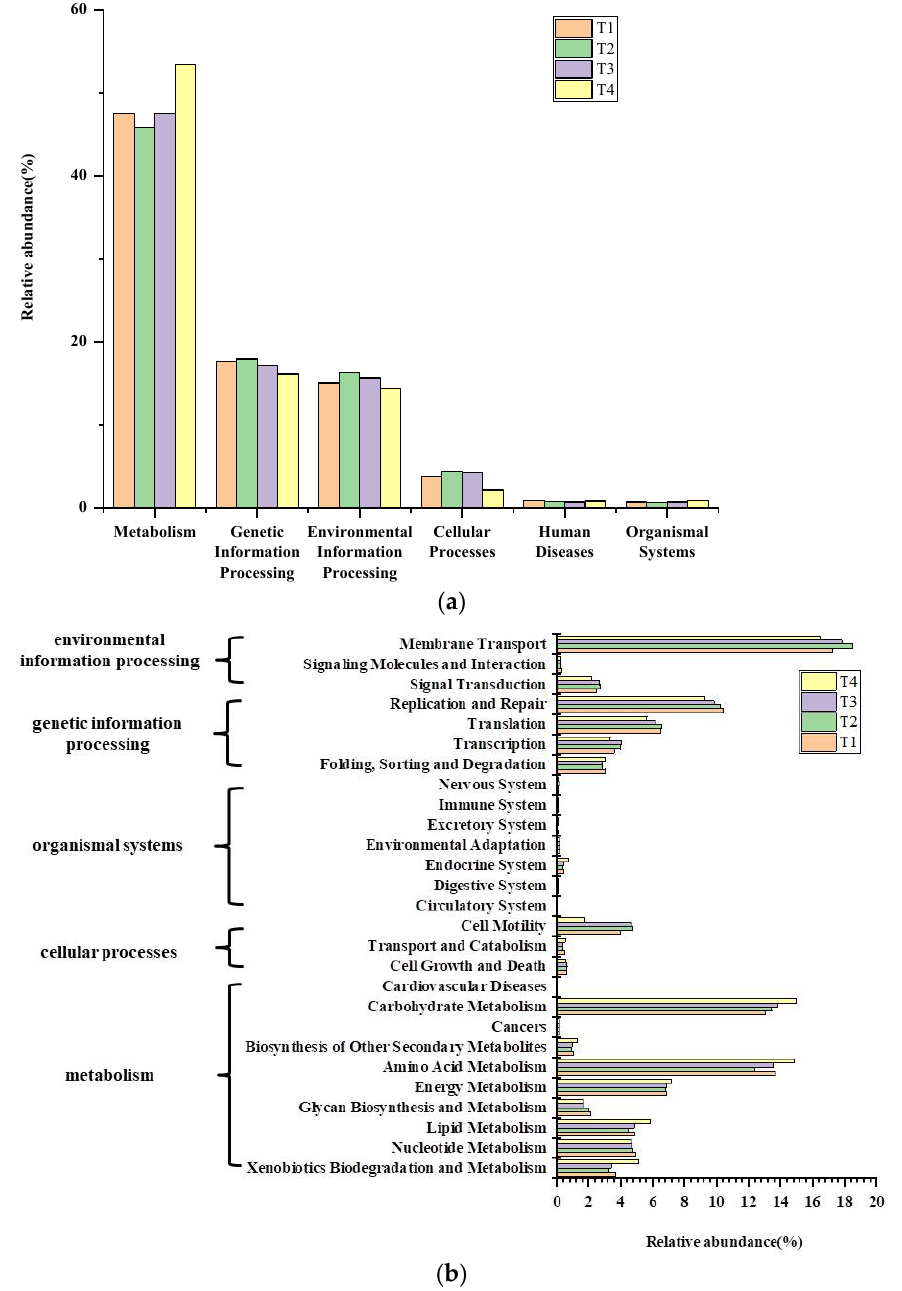
Figure 6. ( a ) KEGG metabolic pathway level 1 characteristics of bacteria. ( b ) KEGG metabolic pathway level 2 characteristics of bacteria.